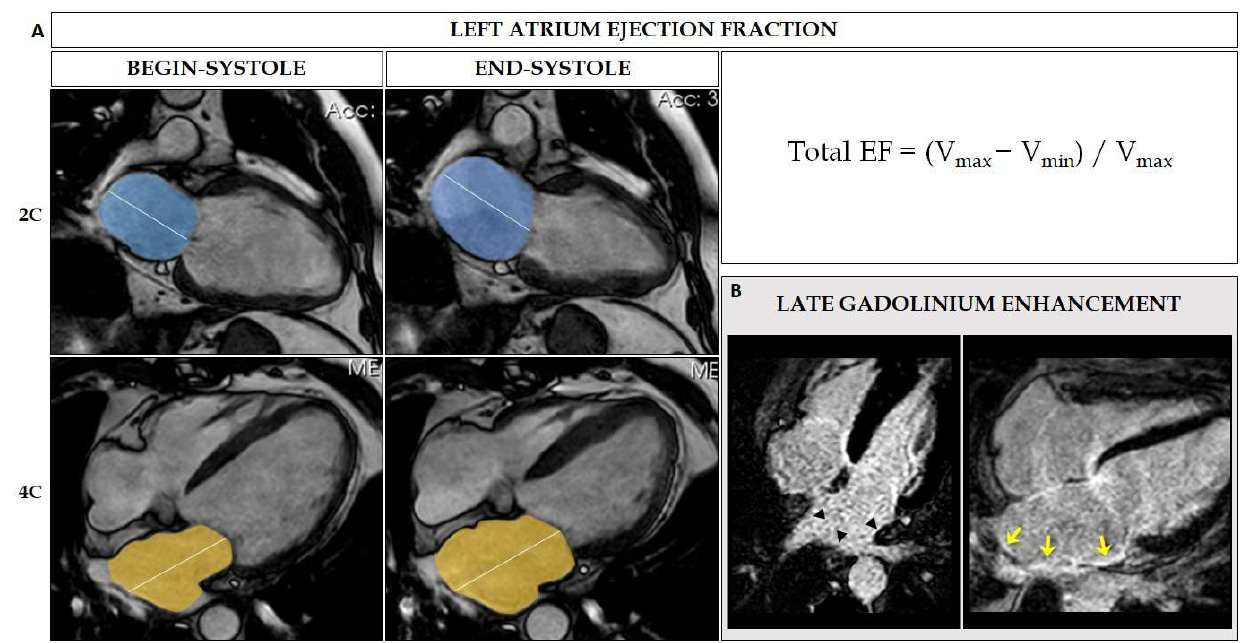
Figure 7. CMR sequences for LA evaluation. ( A ) LA volume and ejection fraction assessment, using two-chamber and four-chamber views, with areas and lengths planimetered (including the formula for the calculation of total ejection fraction). ( B ) Late gadolinium enhancement sequence to identify fibrosis around the PVs and in the LA wall prior pulmonary ablation procedure. ( Left Panel ) Arrowheads demonstrate absence of fibrosis in the atrial wall. ( Right Panel ) Yellow arrows indicate presence of fibrosis in the atrial wall.